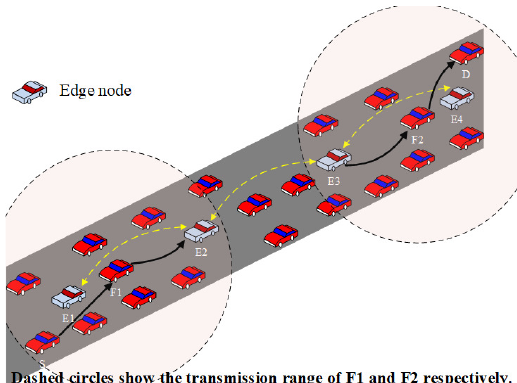
Figure 4. Last two-hop